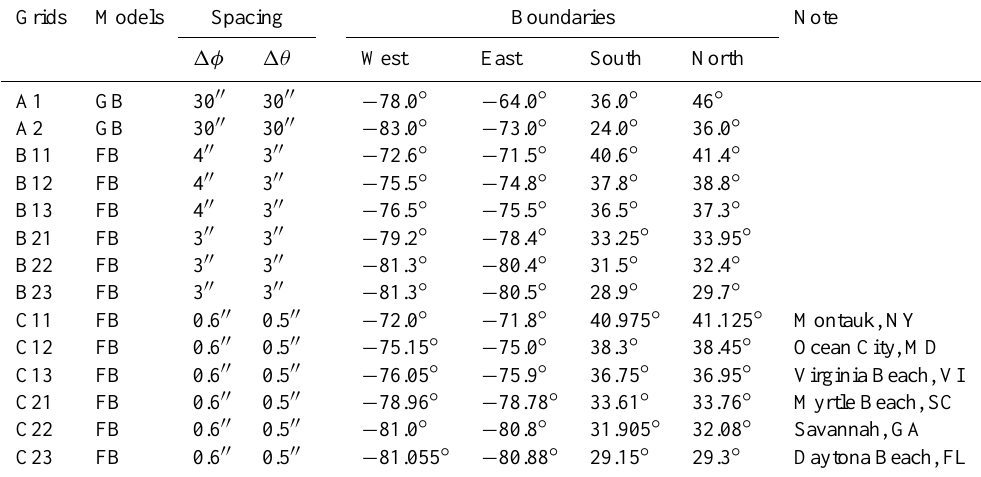
Table 1. Computational Grids along the US east coast.